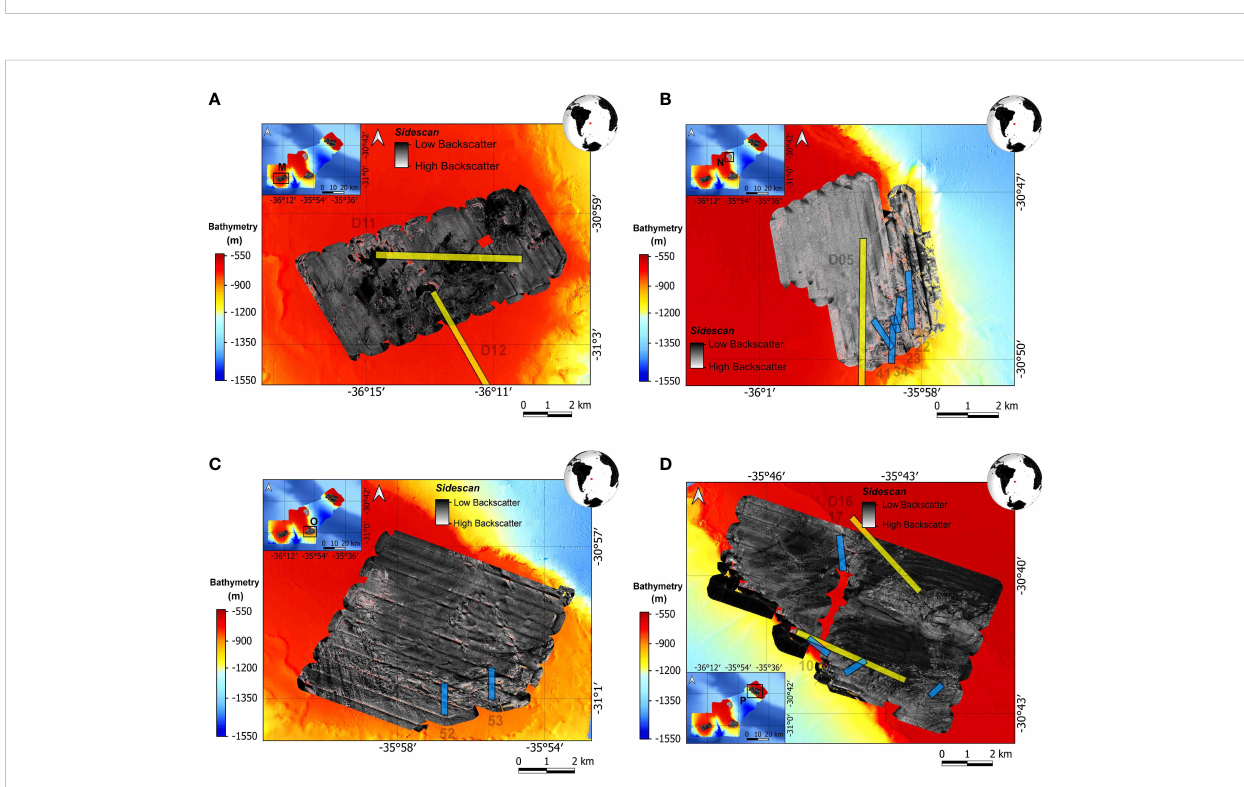
FIGURE 12 Relief maps obtained through AUV missions with a sidescan sonar, and the dredge operations of the RGR-1 (in yellow) and the DY094 (in blue) cruises: (A) Subarea M with dredges D11 and D12, (B) Subarea N with dredges D05, 22, 23, 34, 35 and 41, (C) Subarea O with dredges 52 e 53, and (D) Subarea P with dredges D16, D17, 10, 17, 62 e